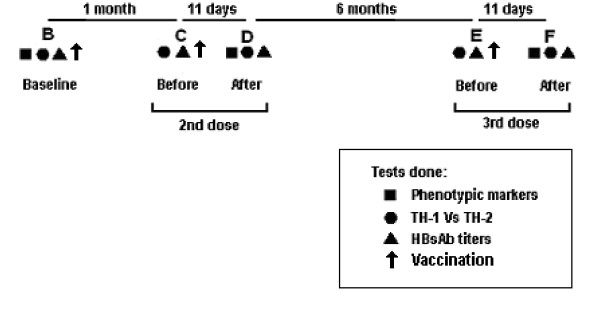
Schematic representation of tests conducted with time schedule.